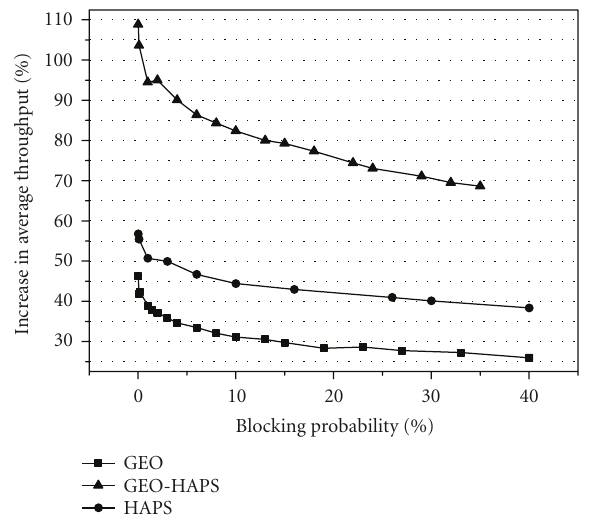
Figure 9: Average throughput increase versus blocking